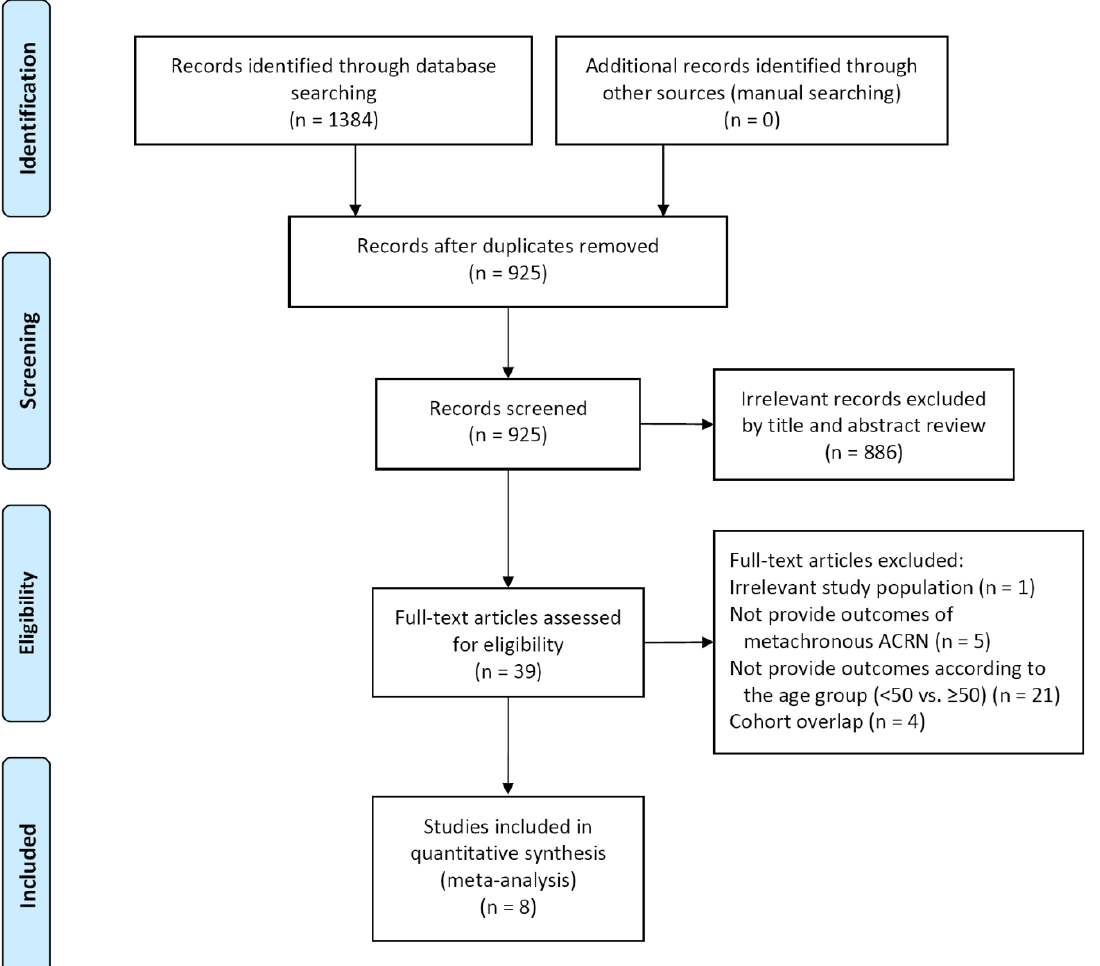
Figure 1. Study flow diagram. ACRN, advanced colorectal neoplasia. Table 1. Baseline characteristics of the included studies and risk of metachronous lesions according to age group.